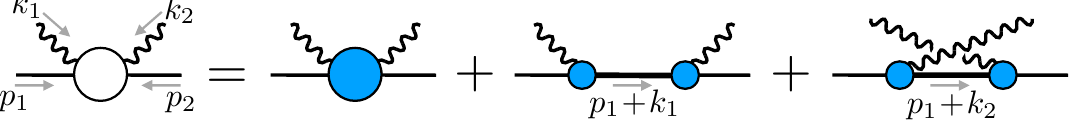
Figure 3 . Skeleton expansion of the (cid:25)(cid:13)(cid:13)(cid:25) amputated connected 4-point function (white blob) in terms of the 1PI proper vertices (blue blobs) and dressed pion propagators (thick lines). where the subscript c indicates that only the connected contribution is kept. We have